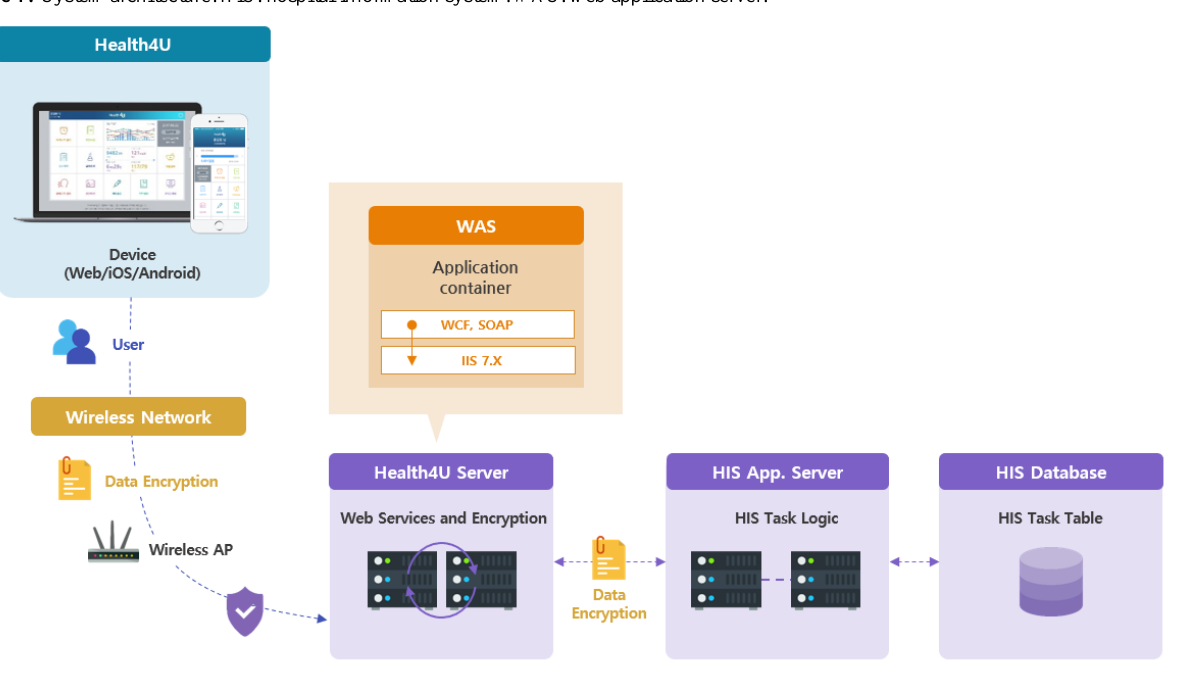
Figure 1. System architecture. HIS: hospital information system. WAS: web application